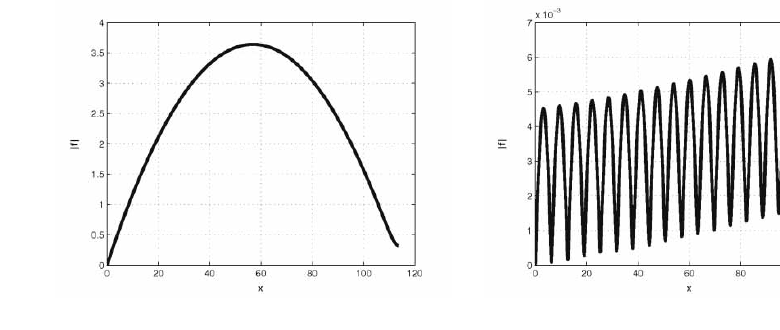
Figure 9. Stationary solution | f | (old), λ = 1, L = 113 . 7, N = 536, δ = 0, I = 0 . 002249.